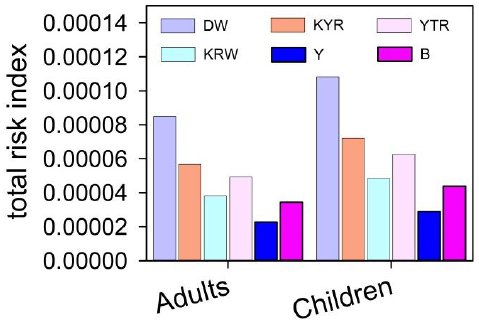
Figure 5. The total value of the human health risk induced by both the carcinogenic and non-carcinogenic chemical pollutants of the different regions of Bay County. KYR: Keyir, KRW: Kariwak, YTR: Yatur, DW: Dawanqi, Y: Yangchang, B: